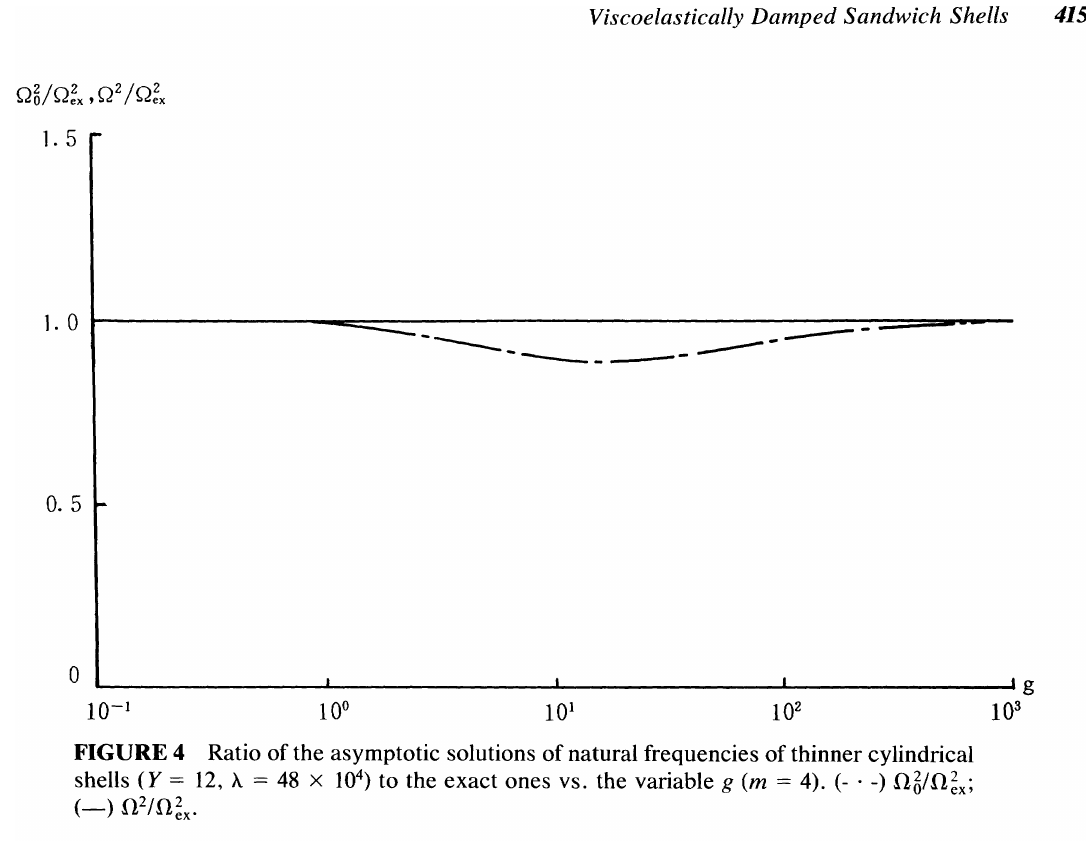
FIGURE 4 Ratio of the asymptotic solutions of natural frequencies of thinner cylindrical 4) shells (Y = 12. A. = 48 X 10 to the exact ones vs. the variable g (m = 4). (- . -) niVn~x;